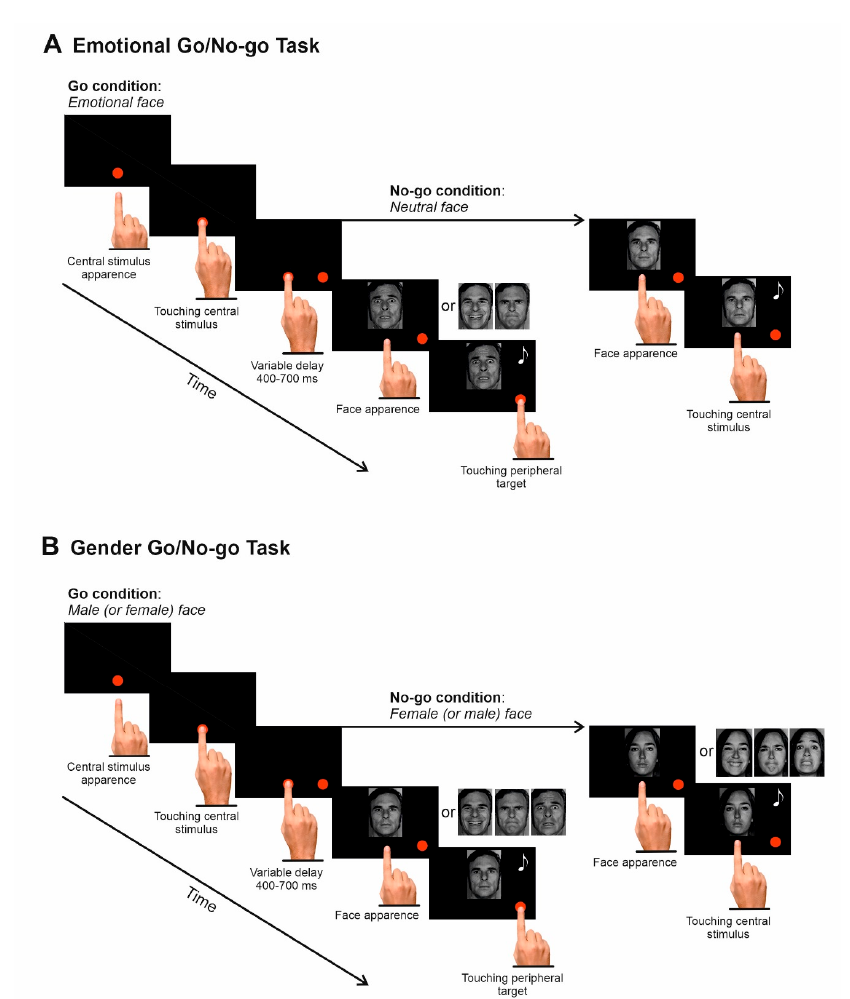
Figure 2. ( A ) Emotion-discrimination task. Each trial started with the presentation of a red circle at the center of the screen. Subjects had to touch it, and, immediately after, a peripheral red circle appeared. After holding the central stimulus for a variable period, it disappeared, and a picture of one of four facial expressions appeared. Participants were instructed to reach and hold the peripheral target when the face expressed an emotion (happiness, fear, or anger. Go condition) or to keep holding the central position when the face displayed a neutral expression (No-go condition). Correct trials were signaled with acoustic feedback (represented in the picture by a musical note). ( B ) Gender discrimination task. The sequence of the events was the same as ( A ). However, in the male version, participants were instructed to reach and hold the peripheral target only when a male face was shown irrespective of the depicted emotion (Go-condition) and to refrain from moving when a female face was presented (No-go condition). Vice versa in the female-version.